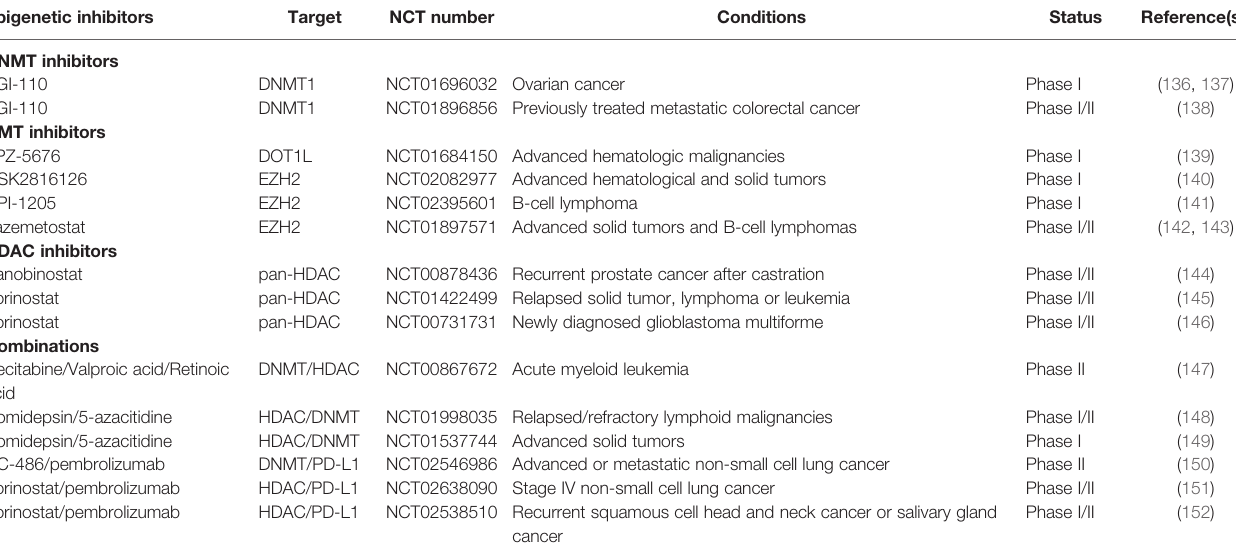
TABLE 1 | Recent clinical